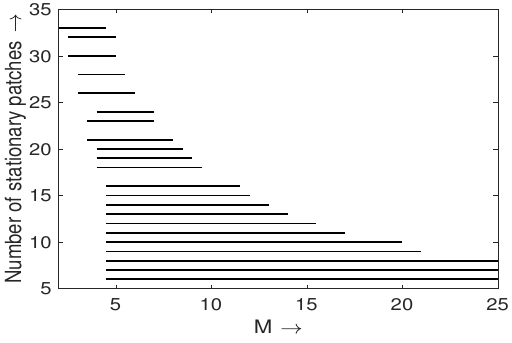
Figure 7. Stationary patterns with various number of patches exist for a range of nonlocal consumption ( M ) is plotted. Parameter values are same as in (24) except d 1 = 0.4 and d 2 =